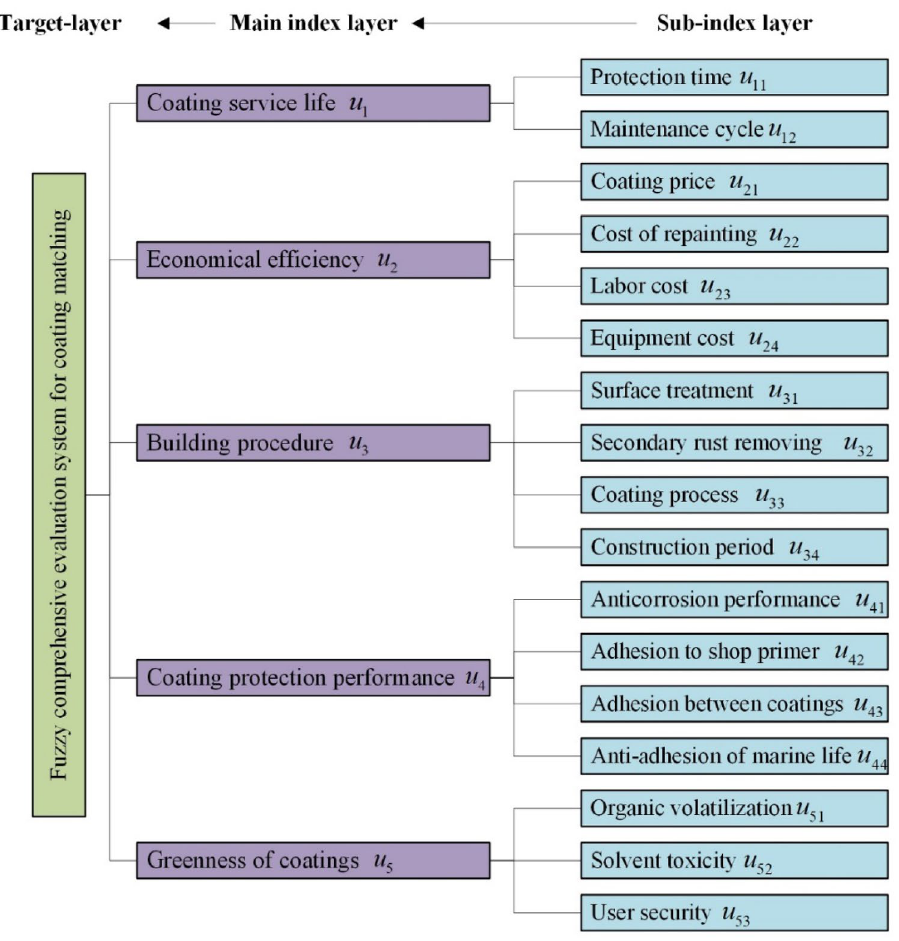
Figure 4. Structure of evaluation indexes for coating matching on flat bottom